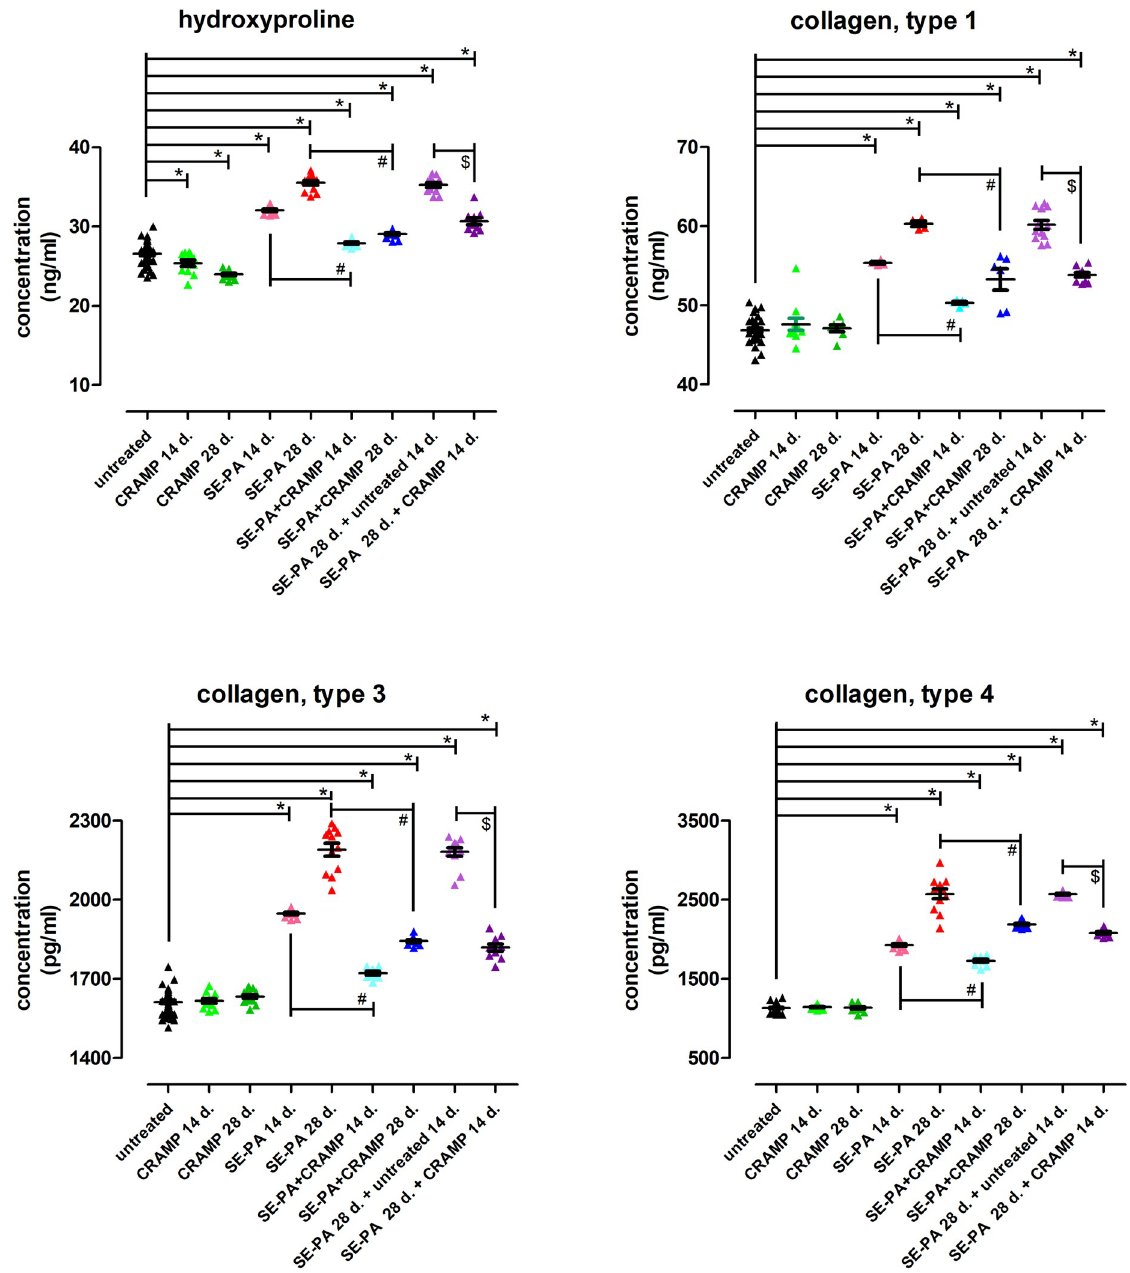
Fig 5. Alterations in collagen deposition in response to cathelicidin (CRAMP) and/or Saline Extract of Pantoea Agglomerans (SE-PA) treatment. Protein concentration was investigated in homogenates of lungs collected from untreated mice and animals exposed to investigated compounds for 14, 28 or 42 days using the ELISA method. The data are presented as a mean of protein concentration ± SEM. Each research group contained 8 mice: 6 treated and 2 untreated animals. Samples were collected from all animals and analyzed in 2 replications. (control mice N = 20; treated mice per research group N = 6). � p < 0.05 vs. untreated; # p < 0.05 SE-PA+CRAMP 14 d./28 d. vs. SE-PA 14 d./28 d. (comparison within corresponding time points); @ SE-PA 28 d. + untreated 14 d. vs. SE-PA 28 d.; $ p < 0.05 SE-PA 28 d. + CRAMP 14 d. vs. SE-PA 28 d. + untreated 14 d.; one-way ANOVA test; Tuckey post-hoc